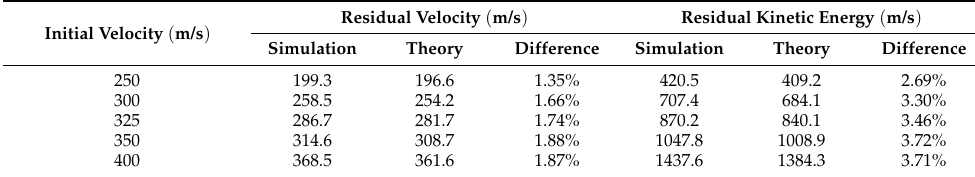
Table 9. Comparison of the results between the theoretical calculations and numerical simulation.